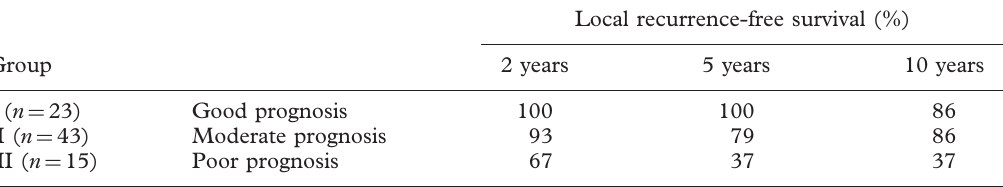
Table 4. Prognostic subgroups of patients with an initial irradical excision of soft tissue sarcoma ( n ¼